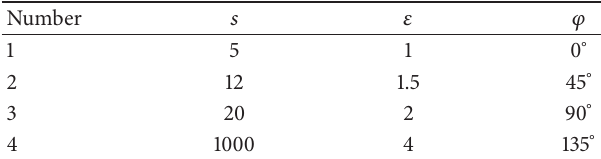
Table 1: Parameters